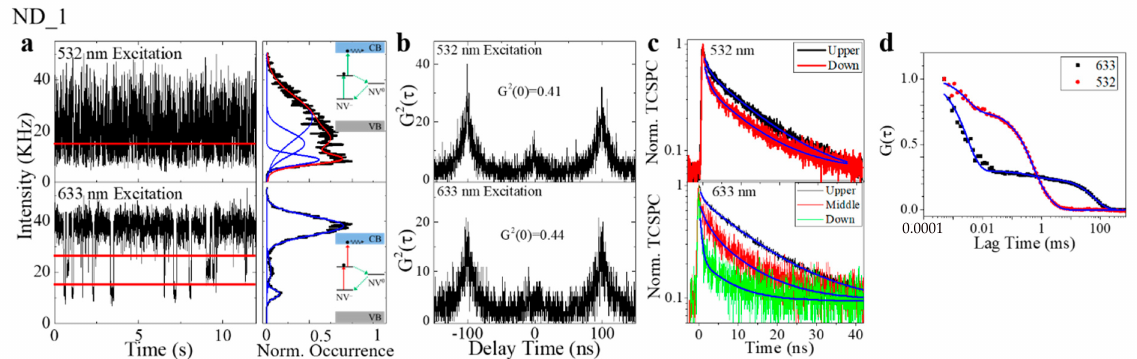
Figure 6. The NV center shows anomalous fluorescence emission phenomena under 532 nm and 633 nm excitations. ( a ) 12-s fragments of a 60-s time trajectory fluorescence emission from a single NV center under the illumination of 532 nm and 633 nm; the histograms are shown correspondingly, and the insets depict the theoretical explanations. Red lines indicate the “threshold” for different states. ( b ) G2 measurements on the NV center under different excitations show the same single photon emission signature. ( c ) Normalized TCSPC decay curves of different states identified in ( a ). ( d ) Normalized ACF curves show different dark-state dynamics under 532 nm and 633 nm